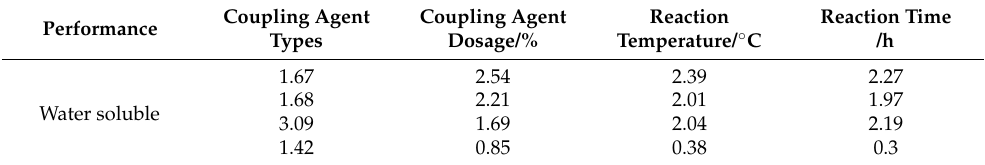
Table 5. Results of extreme difference